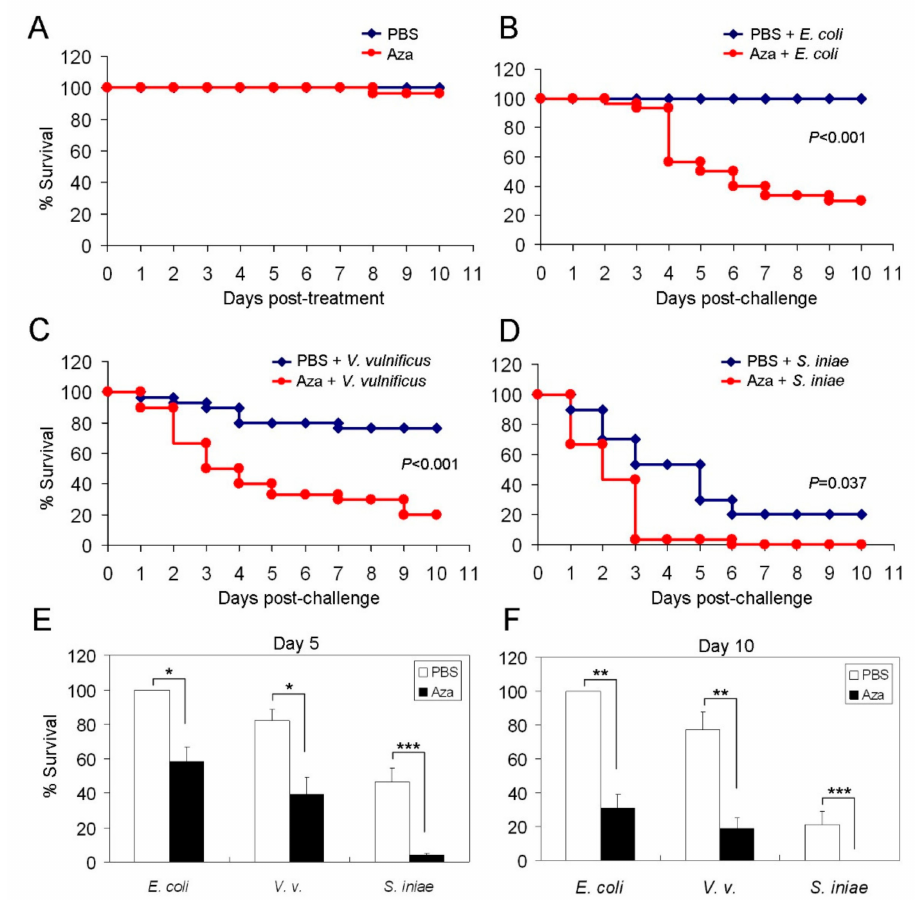
Figure 4. Increased susceptibility to bacterial infection in azacitidine-treated zebrafish. The Kaplan–Meier survival curve of zebrafish pretreated with PBS or azacitidine (Aza) (3 µ g) for three days only ( A ), or followed by a challenge with ( B ) E. coli (10 7 colony-forming units (CFU)), ( C ) V. vulnificus (10 5 CFU) or ( D ) S. iniae (10 3 CFU), n = 30 for each group, analyzed by the Kaplan-Meier log rank test. The Day-5 ( E ) and Day-10 ( F ) survival rates are shown. Results are mean ± SD of three independent experiments. * p < 0.05, ** p < 0.01, *** p < 0.001, by Student’s t test. 2.4. Increased Susceptibility to Bacterial Infection by Iron Overload in Azacitidine-Treated